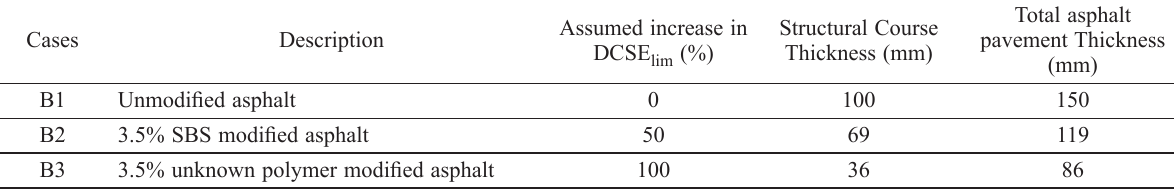
Table 1. Asphalt pavement layer thicknesses for different cases (B)